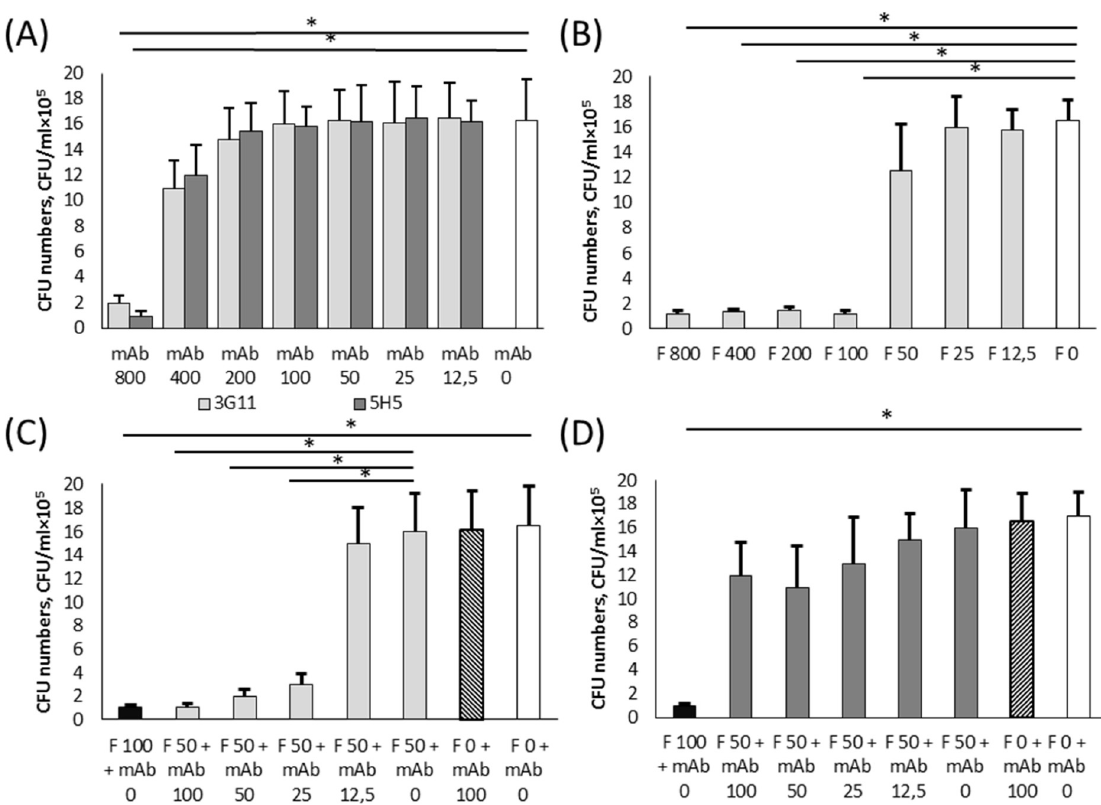
Fig 7. Antifungal activity of mAbs 3G11 and 5H5 and fluconazole. Two-fold dilutions of mAbs 3G11 or 5H5 (A) , fluconazole (B) , fluconazole with mAb 3G11 (C) , or fluconazole with mAb 5H5 (D) were added to an overnight C . albicans culture (10 5 CFU/mL), and the mixtures were incubated at room temperature with shaking for 18 h. After incubation, aliquots were collected, serially diluted and plated on Sabouraud Dextrose agar, and the plates were incubated overnight at room temperature. The colonies, which grew on the plates, were counted. All experiments were carried out twice in triplicate. When fluconazole and a mAb were added simultaneously, fluconazole at a concentration of 100 μ g/mL and sterile 0.9% NaCl were used as positive and negative controls, respectively. The limit of quantification by this method was 100 CFU/mL. The data are indicated as a mean value ± s.d. A two-tailed Student’s t- test was used to determine significance; � p < 0.01. Abbreviations: F.–Fluconazole; mAb–appropriate mAb; numbers indicate fluconazole and mAbs concentrations in μ